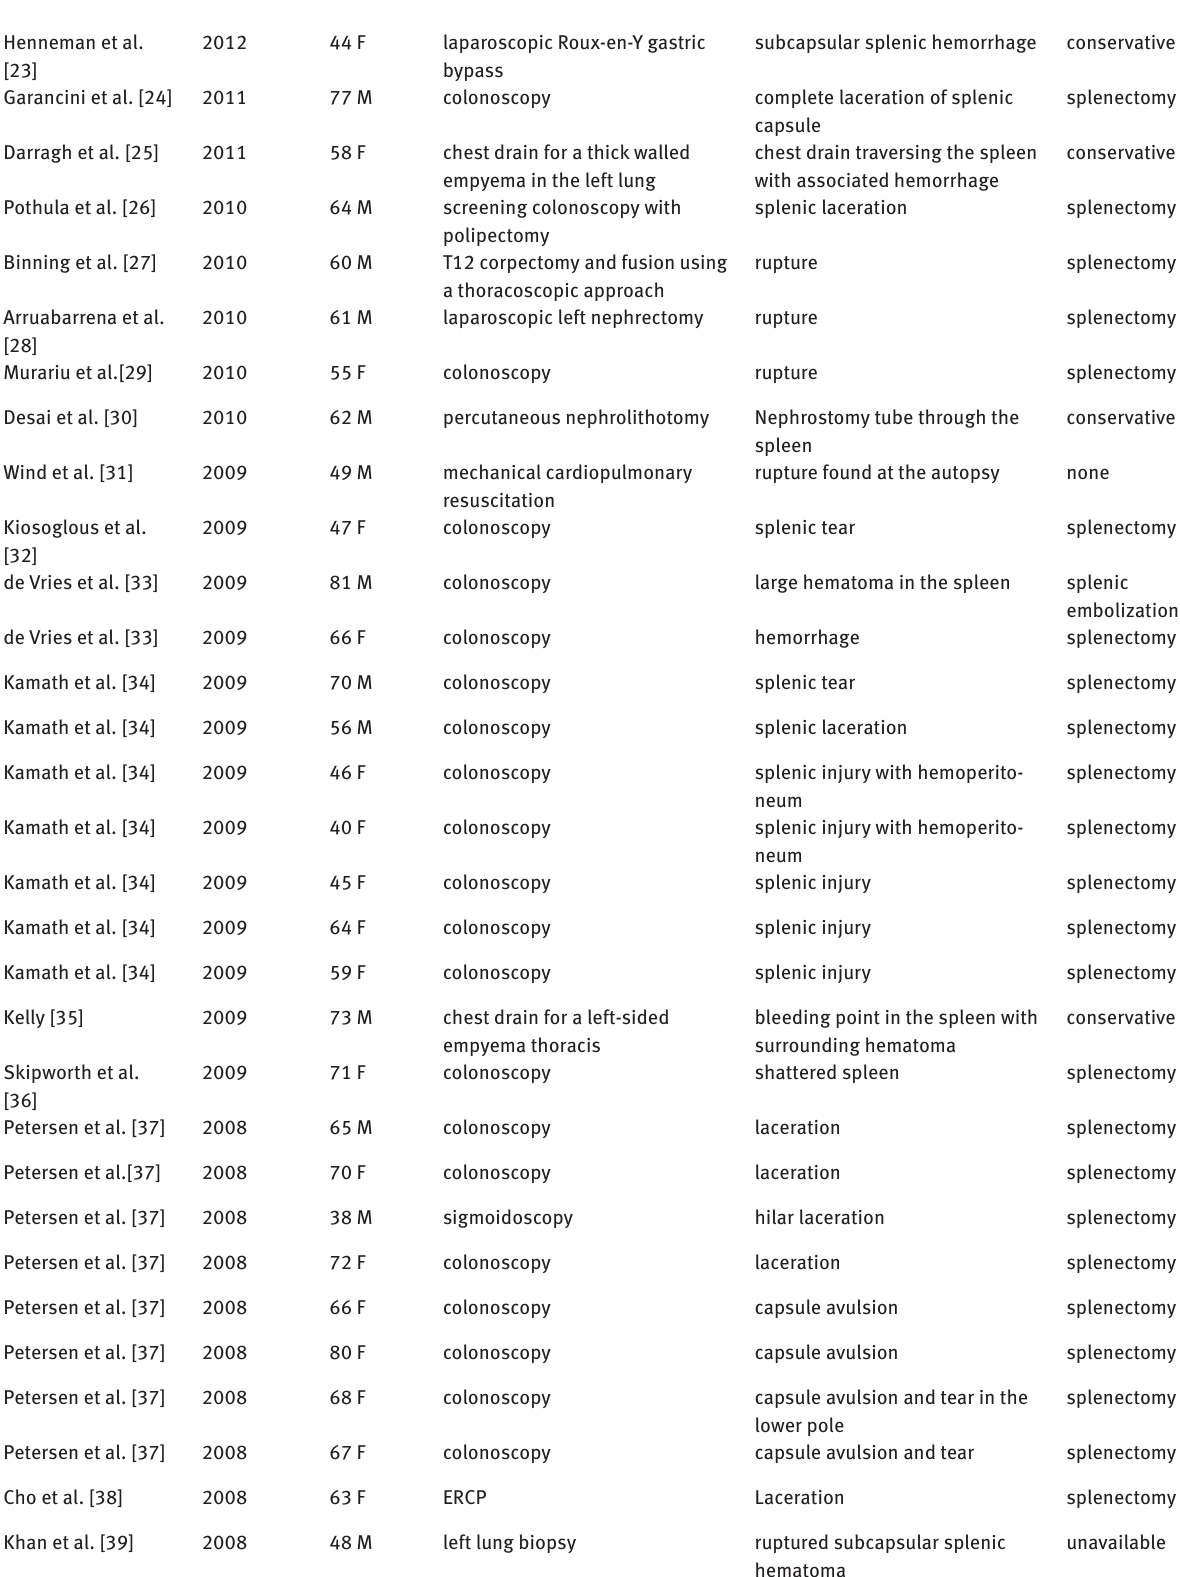
Table 1 continued: Cases selected from the